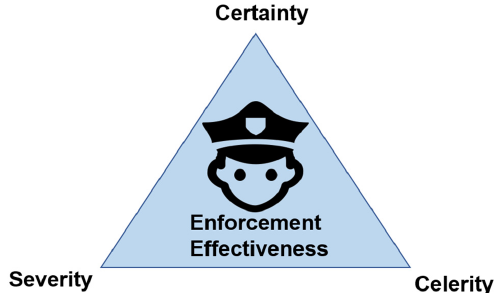
Figure 1. Conceptual framework of the research.